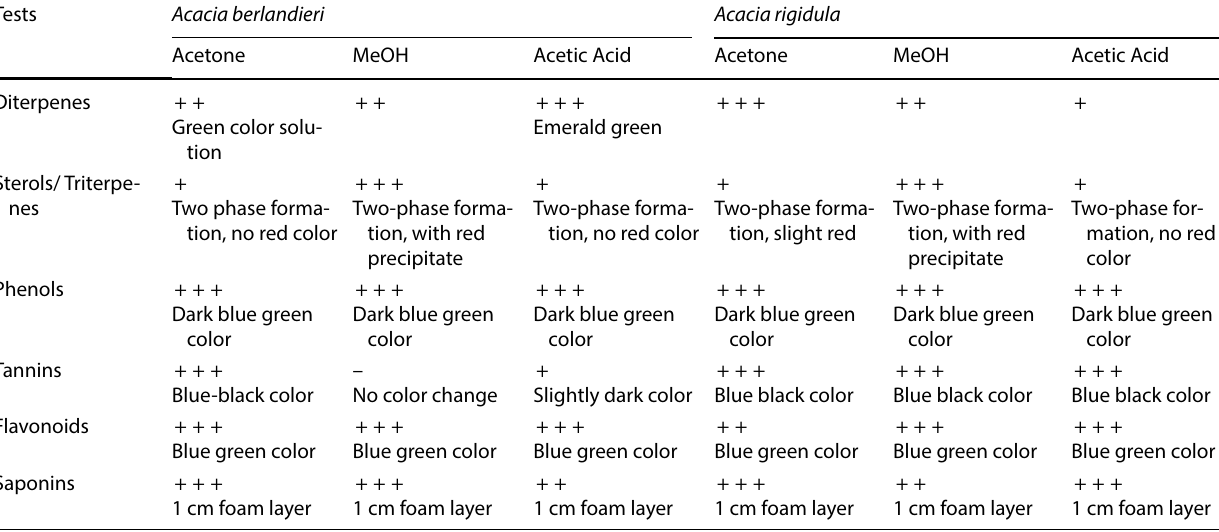
The compounds, which were clearly present was symbolized as (+ + +), fairly present as (+ +), slightly present as ( +), whereas negative reac- tions ( −) represent the absence of those particular compounds in respective extracts. All extracts were negative for alkaloids and therefore are not included in